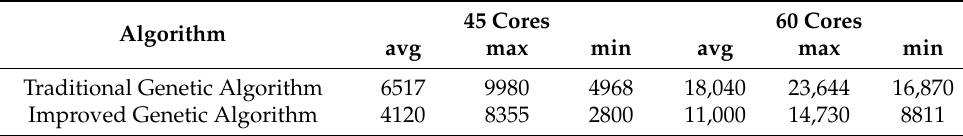
Table 1. Random task graph power consumption comparison (mJ).